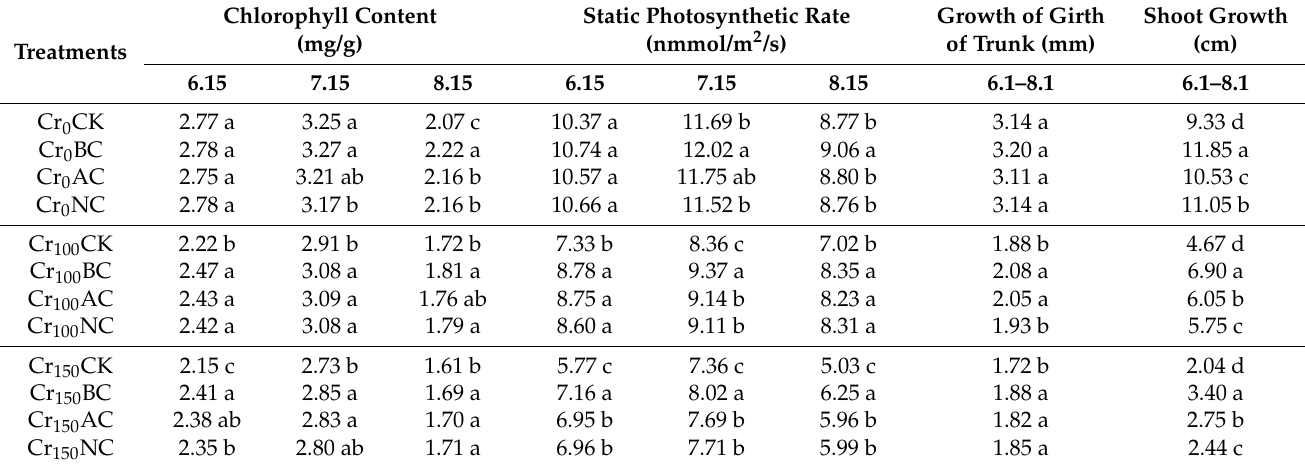
Table 3. Effects of BC, AC, and NC application on the growth of peach trees under Cr